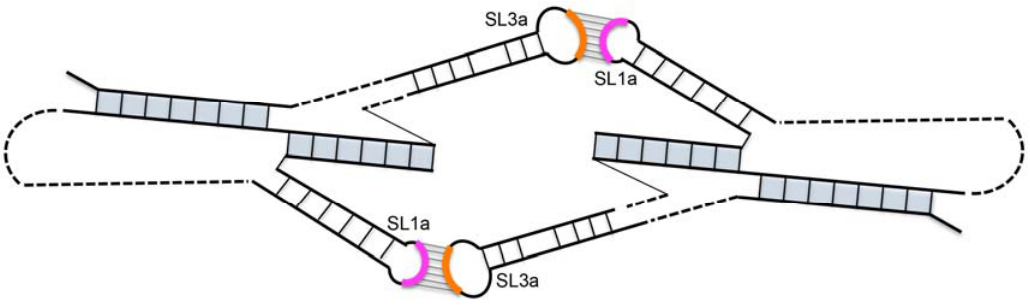
Figure 3. Model of a symmetrical Ty1 RNA kissing complex containing two Ty1 RNA pseudoknots interacting via two 7 ‐ base ‐ pair intermolecular RNA duplexes formed between apical motifs in stem ‐ loop SL1a (pink arc) and SL3a (orange arc). The pseudoknot stems are shaded in blue.